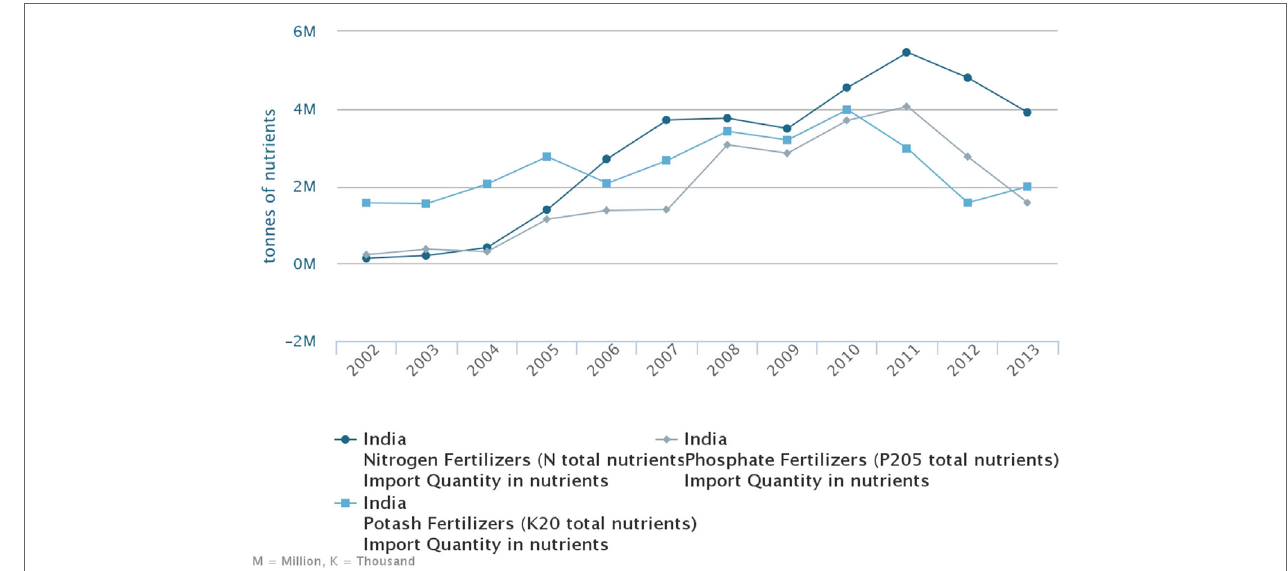
FigUre 5 | Indian import of fertilizers N, P, and K (total nutrients). Source: